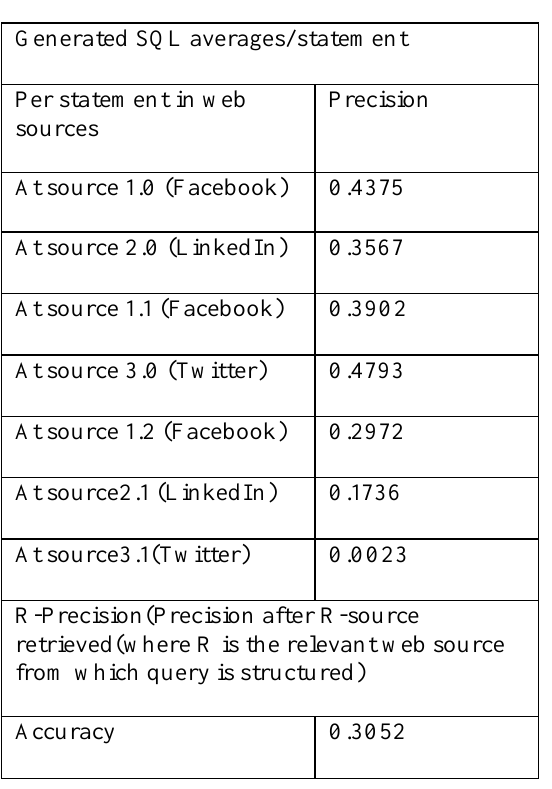
Accuracy Table for Social Web Source